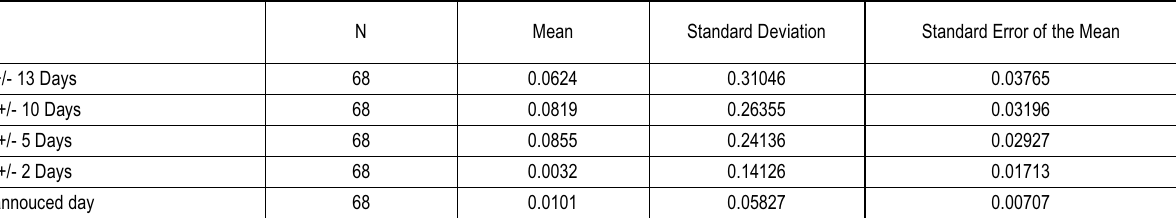
Table no. 1. Statistics for normal stock splits